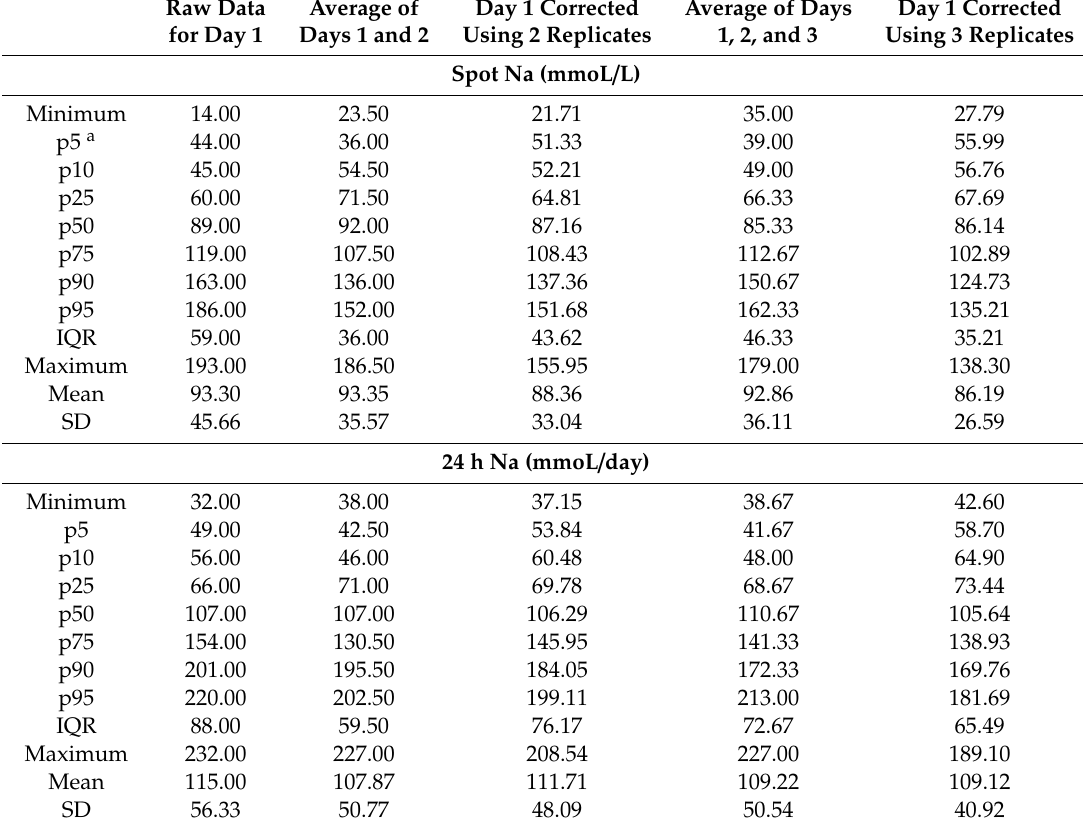
Table 3. Spot and 24 h Na urinary concentration distribution, raw data from day 1, after correction for intra-individual variation of two and three spot sample collections and averages of multiple